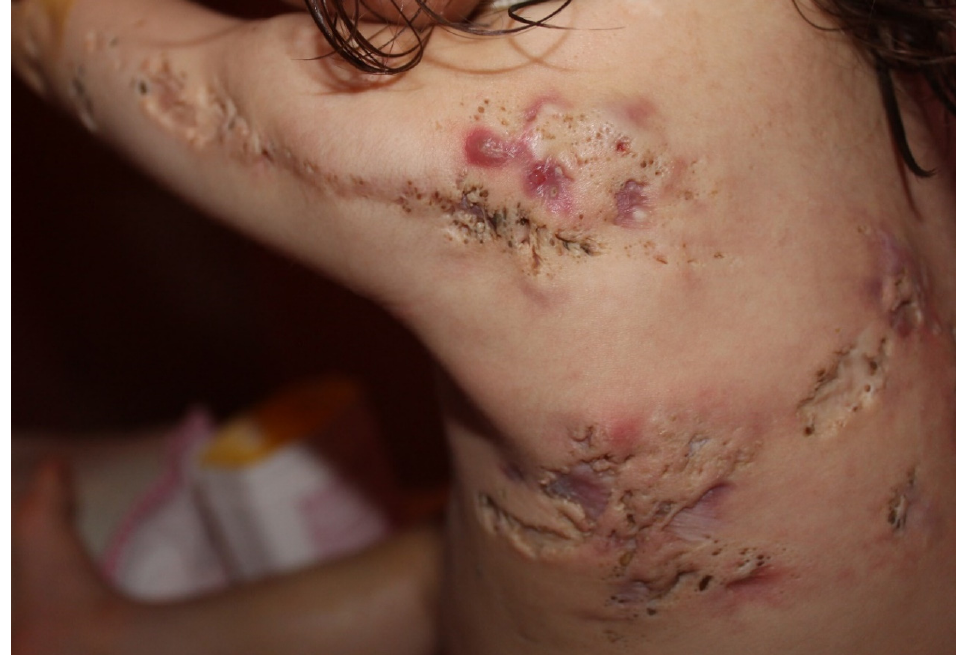
Figure 7. Nevus comedonicus. Multiple nodulocystic lesions, atrophic scars, fibrous tracts, and grouped comedone-like pits scattered unilaterally on the left side of the trunk, superior limb and the retro-auricular area of a 2 year and 7-month-old girl, born of a non-consanguineous marriage. Courtesy by Prof. Anca Chiriac, Department of Dermatology, Nicolina Medical Center, Apollonia University, Ia ș i, Romania.